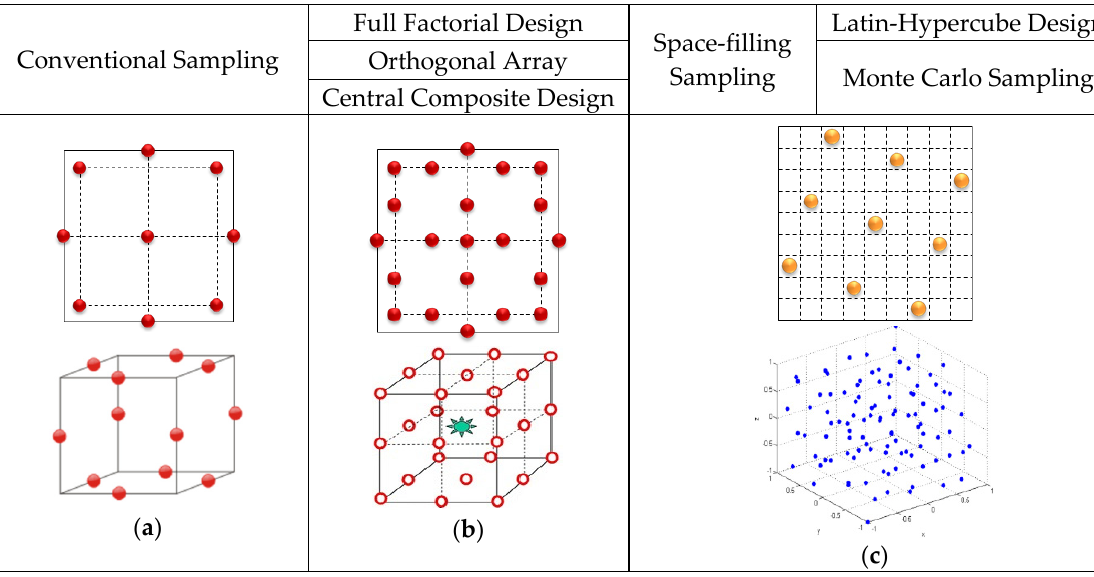
Figure 5. Arrangement method of experiment points according to DOE's technique ( a ) 3 level ( b ) 5 level ( c ) random.